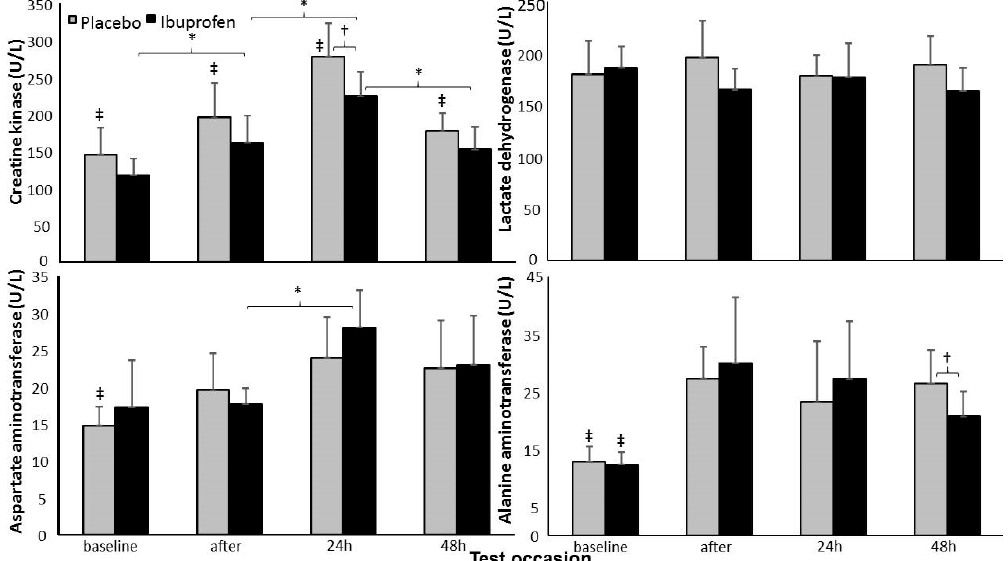
Figure 2. Mean (±SD) creatine kinase, lactate dehydrogenase, aspartate aminotransferase and alanine aminotransferase concentrations before, straight after, post-24 h and post-48 h after a heavy bench press with placebo vs. ibuprofen ingestion protocol. * = significant difference between these two testing times for this condition ( p < 0.05); † = significant difference between conditions of exercise ( p < 0.05); ‡ = significant difference from all other testing times for this condition ( p < 0.05). Muscle temperature decreased significantly from baseline to 24 h after the placebo intervention for the deltoid muscle and from 24 to 48 h for the deltoid and triceps muscles. The temperature rose significantly at 48-h post-exercise in the ibuprofen condition, when compared with the previous day of measurement; and deltoid muscle temperature at 48-h post-exercise was higher with the ibuprofen condition compared with placebo. Significant differences in triceps muscles at 24 h and deltoid muscle, 48 h between the two conditions were observed, with higher mean values in the ibuprofen condition. (Figure 3).